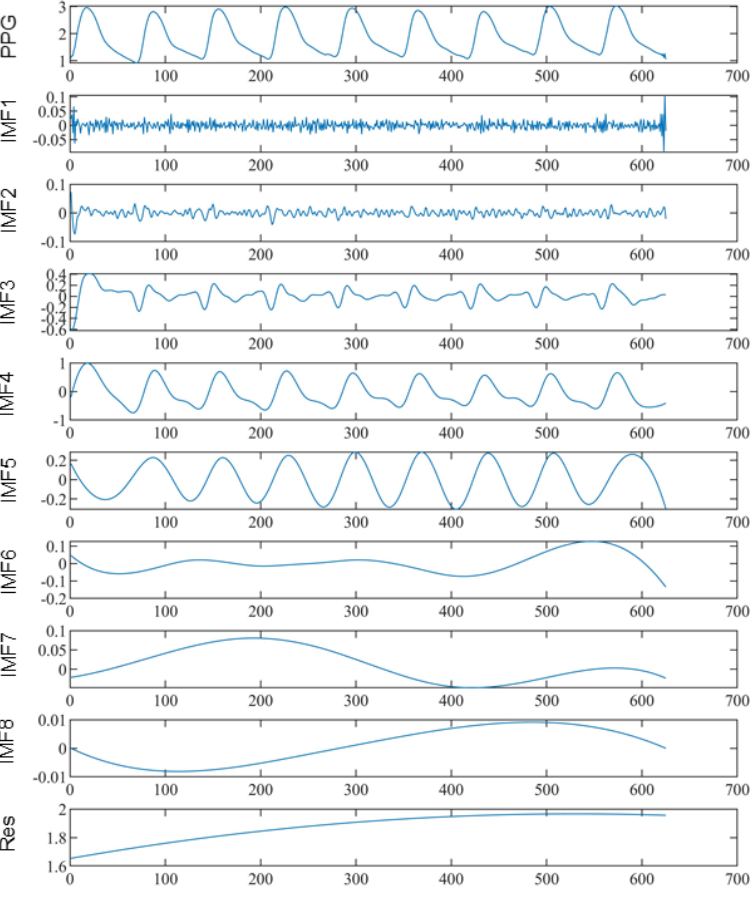
Figure 5. EEMD decomposition of PPG.